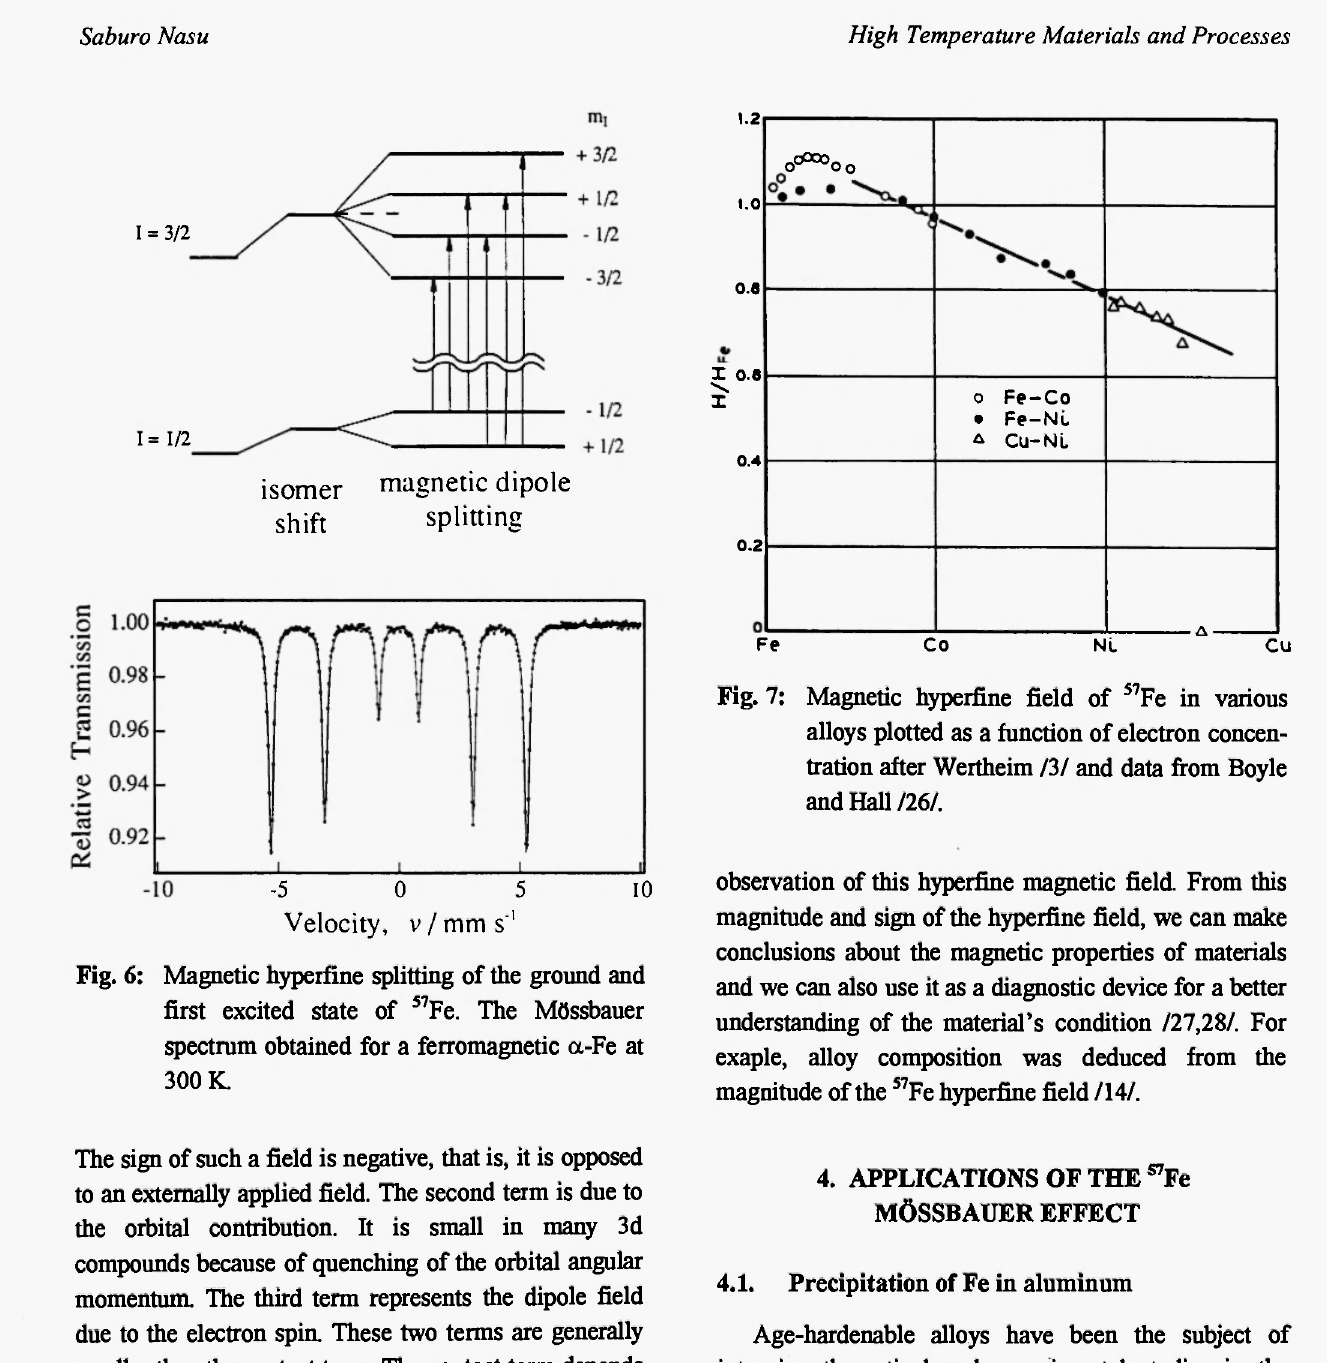
Fig. 6: Magnetic hyperfine splitting of the ground and first excited state of 57 Fe. The Mössbauer spectrum obtained for a ferromagnetic α-Fe at 300 K.